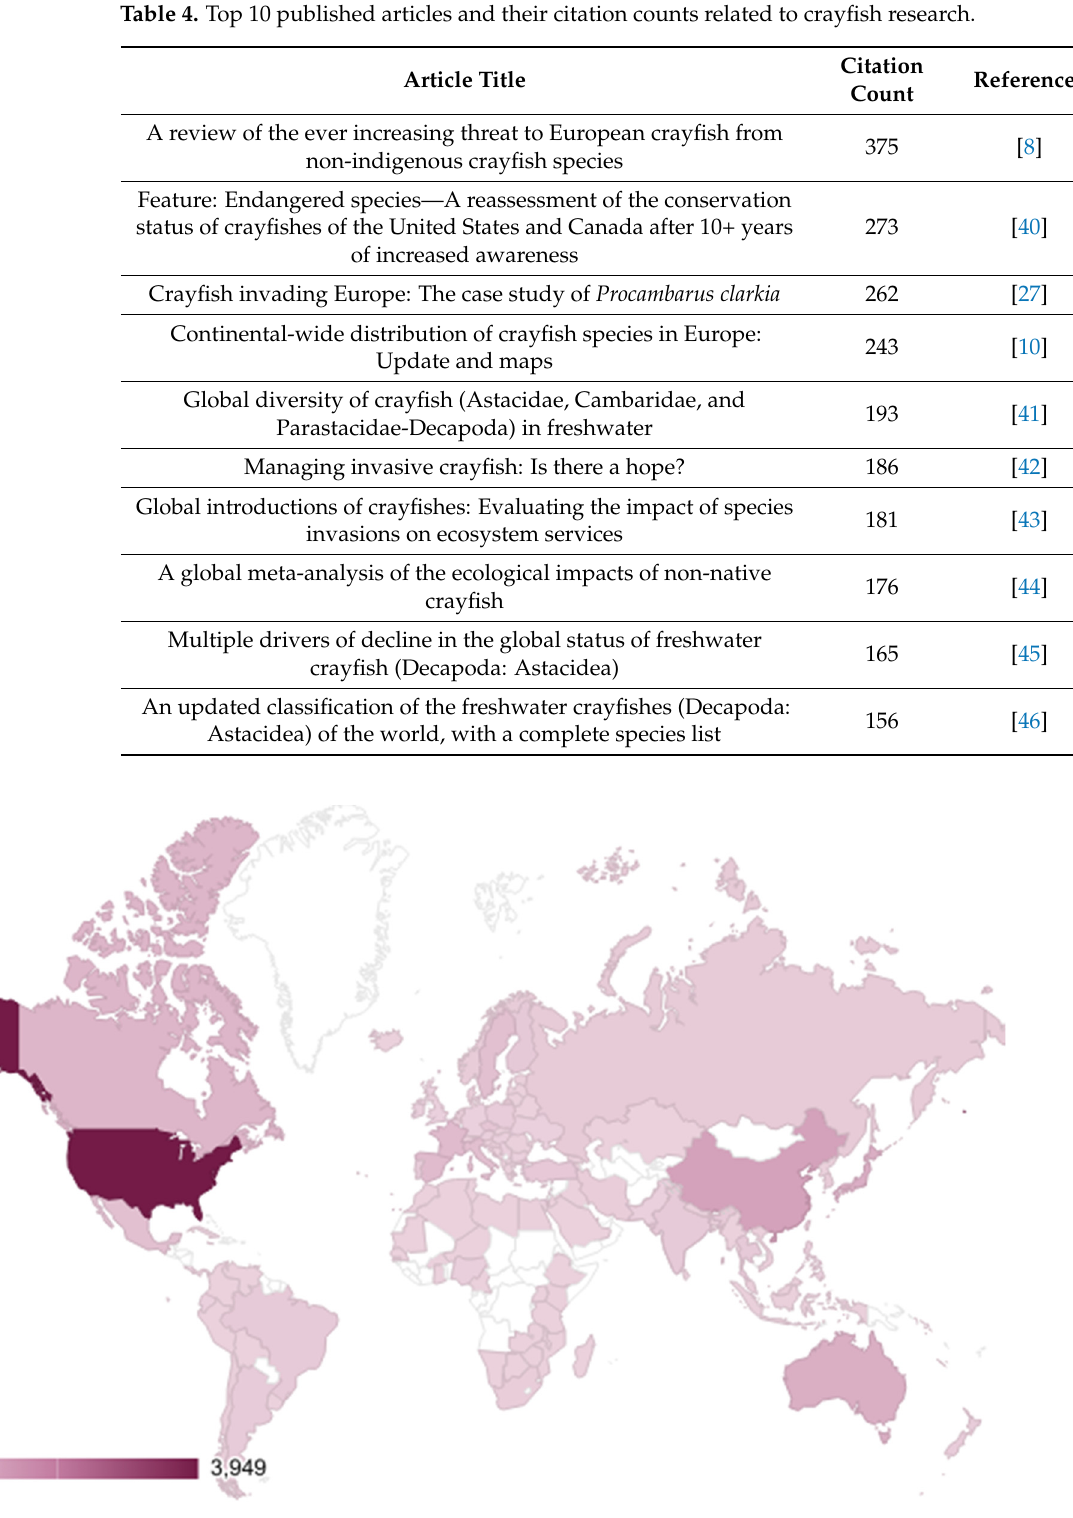
Figure 3. Total publications per nation for crayfish research. Dark magenta represents the highest number of publications, whereas lighter shades represent fewer publications.